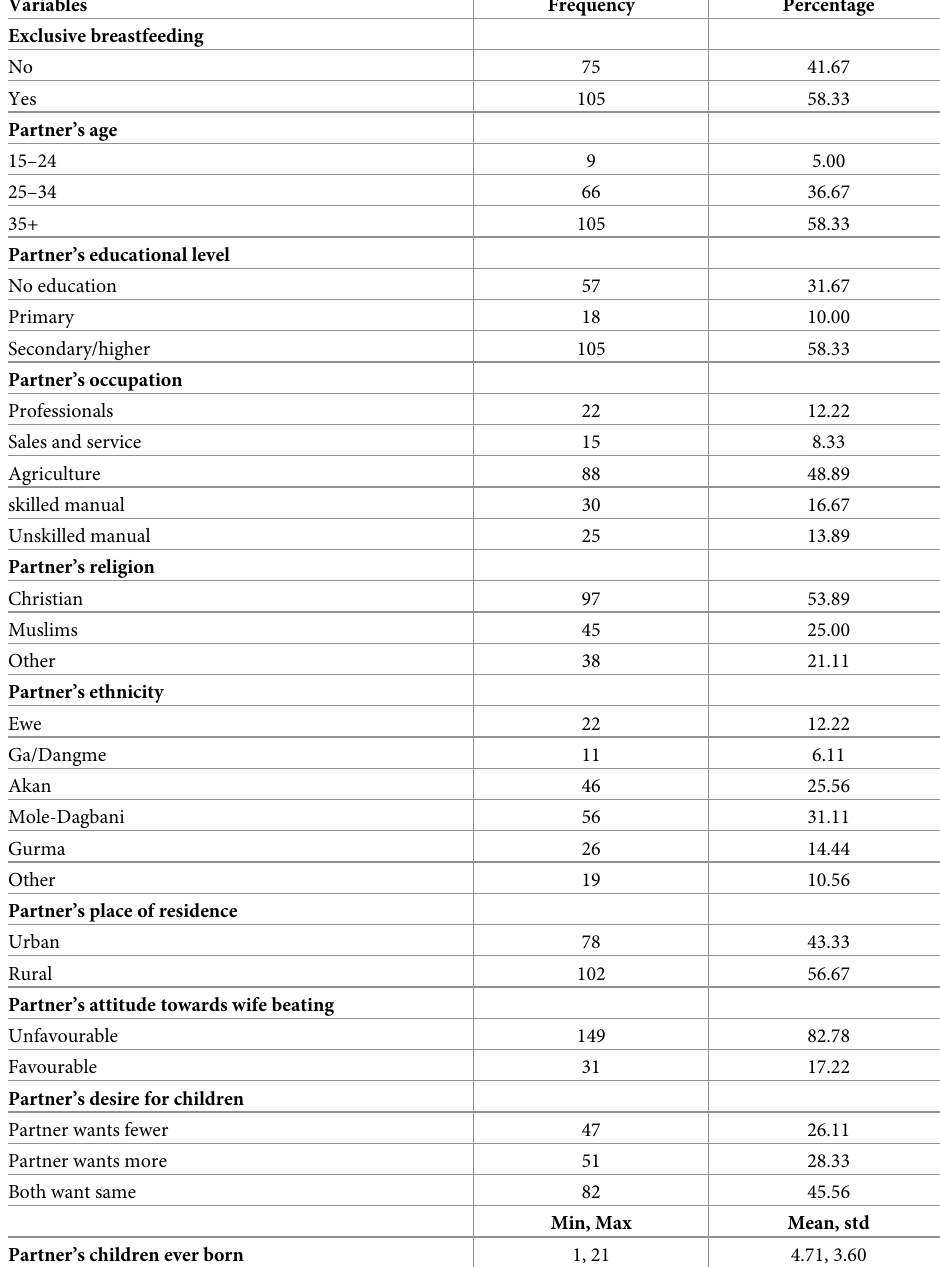
Table 1. Description of exclusive breastfeeding and partner’s